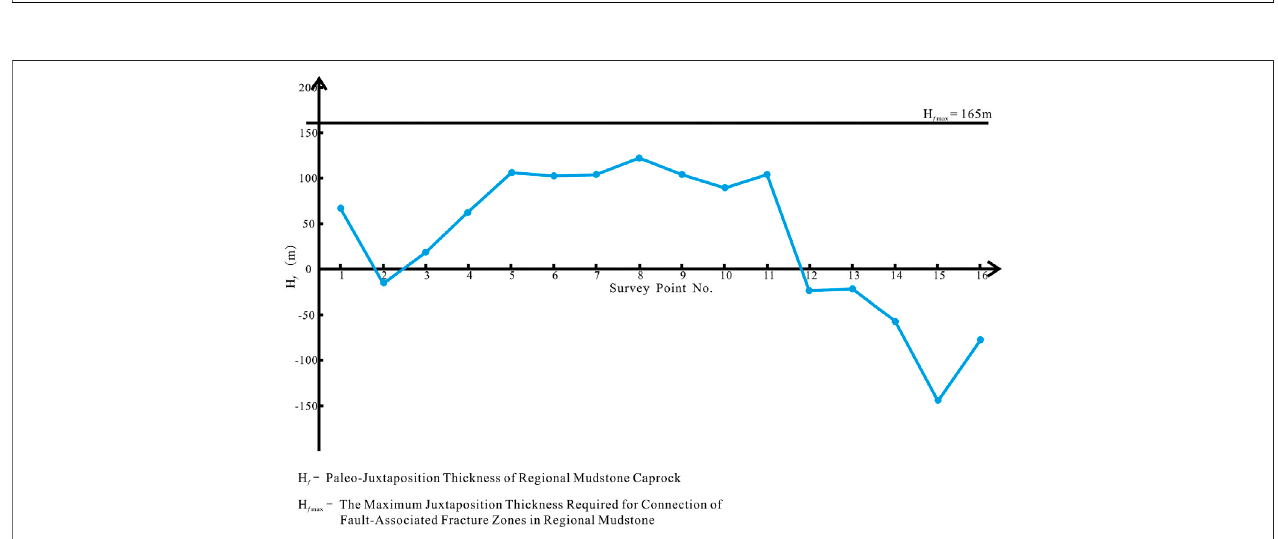
FIGURE 7 | Paleo-juxtaposition thickness distribution of the regional mudstone caprock of E 3 s 1M in the Zhangdong Fault during the hydrocarbon accumulation period.